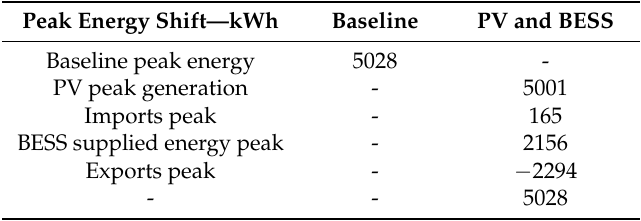
Table 8. Peak energy shift analysis of 3 kW PV and 9 kWh BESS.